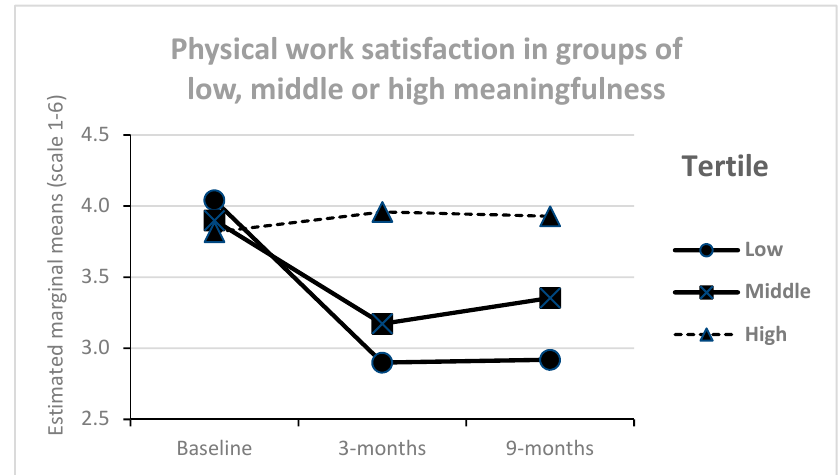
Figure 5. Physical work satisfaction over time in groups with different levels of perceived meaningfulness in the process ( n = 246).